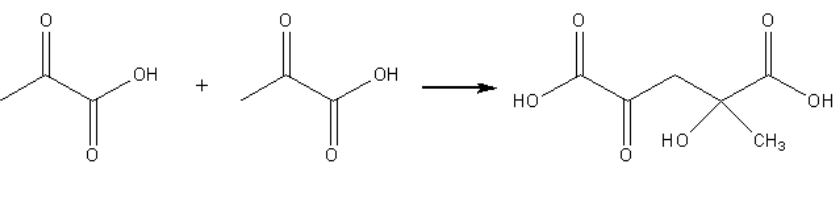
Fig. 5. Aldol reaction of puruvic acid, the product of decarboxylation of oxosuccinic